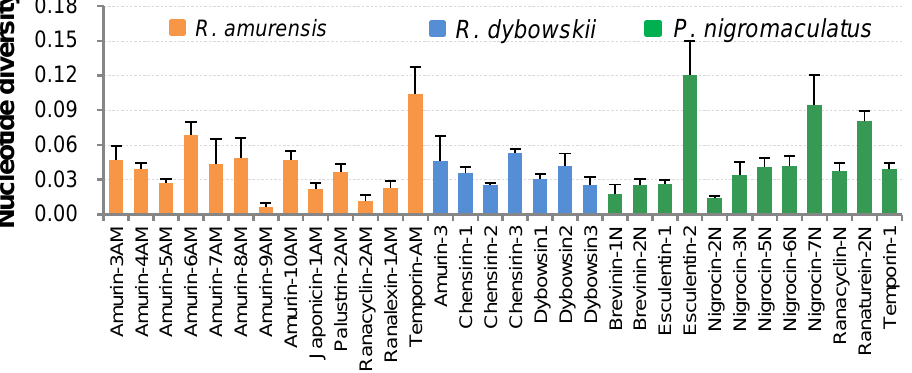
Figure 4. Nucleotide diversity ( ± SD) of antimicrobial peptide (AMP) families identified from the three anuran species.